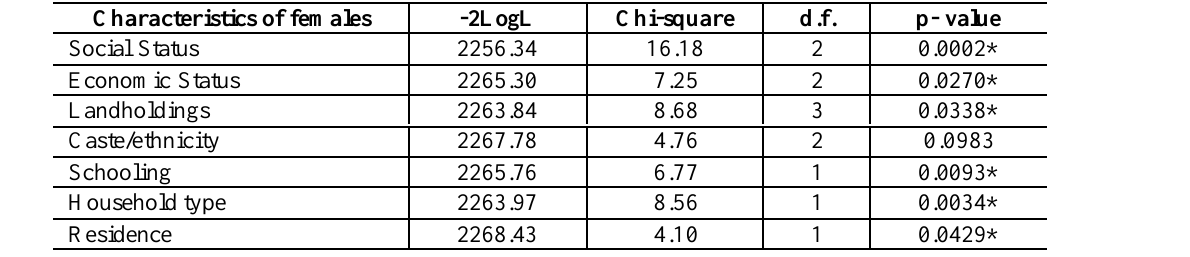
* calculated from the females (mothers) corresponding to daughters given in the last two columns Table II : Univariate hazard model analyses for the age at menarche